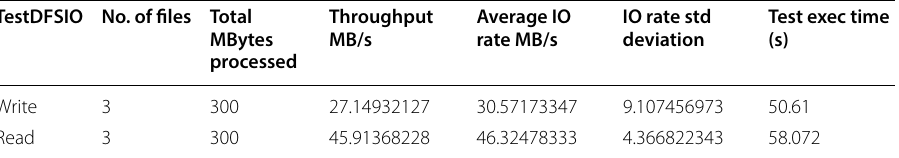
Table 2 Benchmarking the cluster TestDFSIO No. of files Total